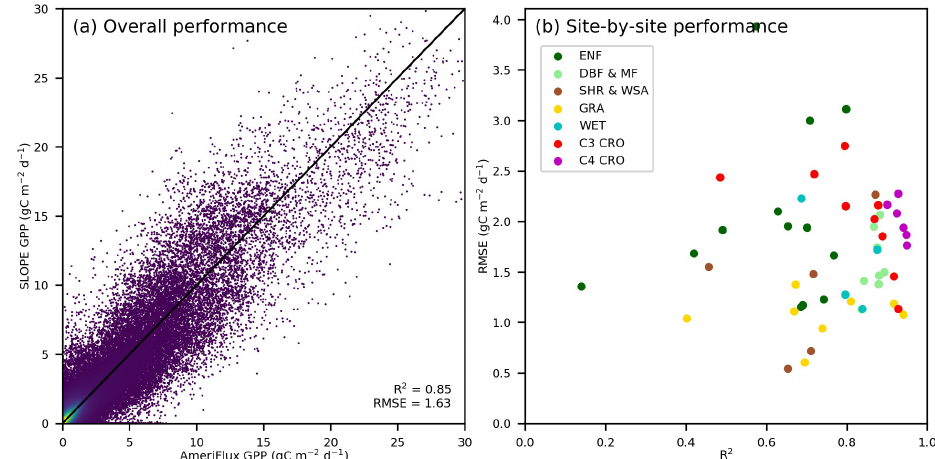
Figure 14. Performance of the SLOPE GPP. (a) Comparison between AmeriFlux GPP and SLOPE GPP across all sites. (b) R 2 and RMSE of individual sites. Sites with a C3–C4 rotation are separated into C3 CRO and C4